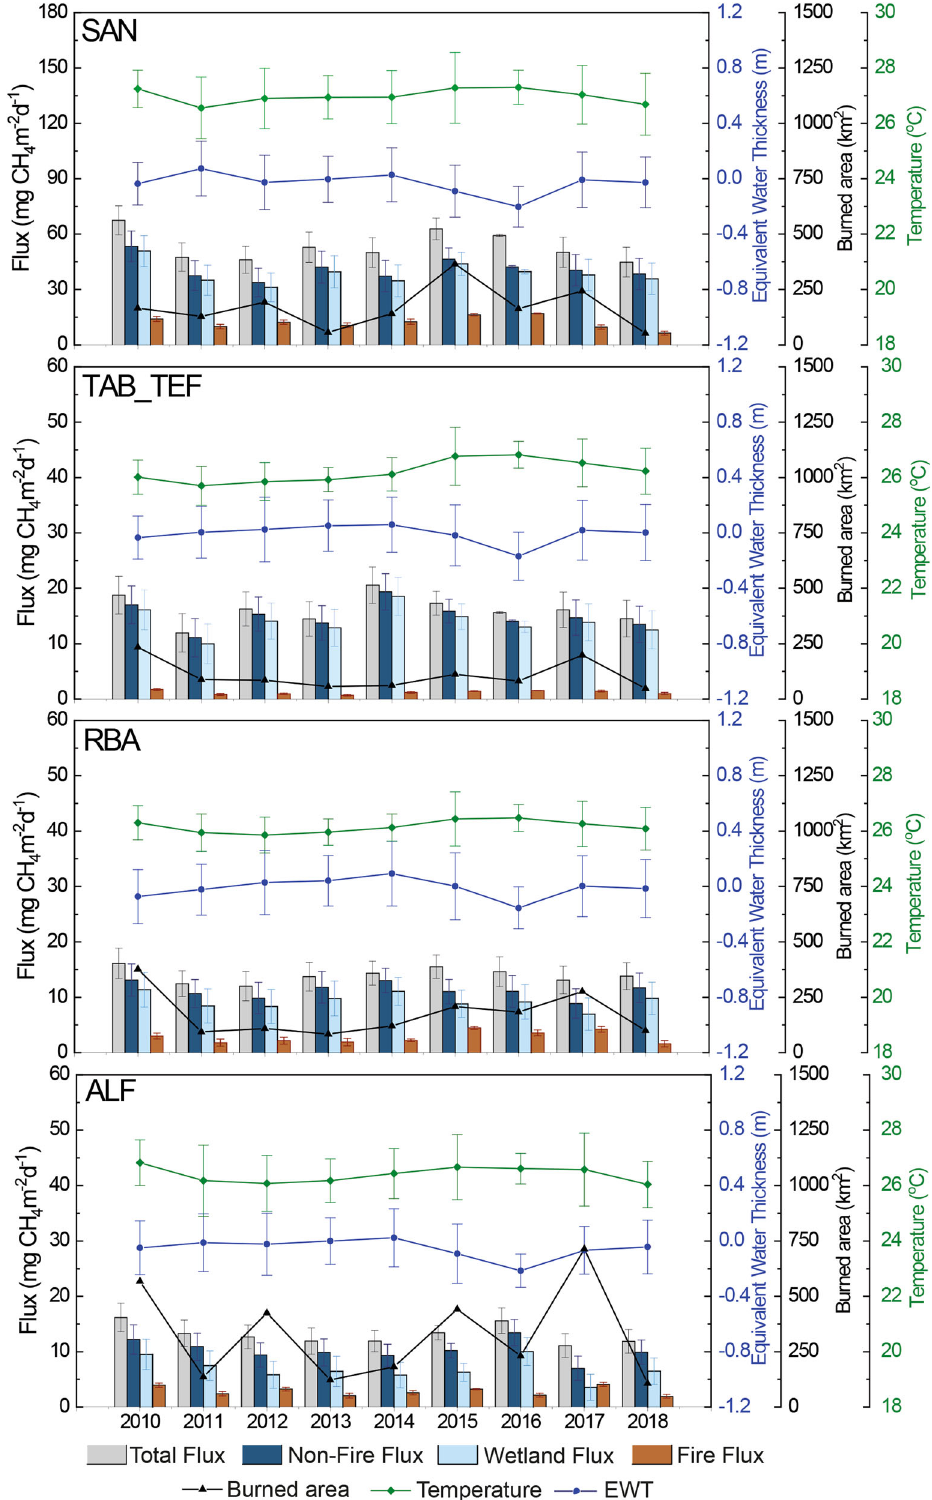
Fig. 4 Annual mean CH 4 fl uxes estimated using vertical pro fi les. Colours and fl uxes are de fi ned as in Fig. 3. Annual mean error bars represent the uncertainty estimated by Monte Carlo error propagation (Methods); temperature, burned area and EWT error bars represent the standard deviation of monthly means over 9